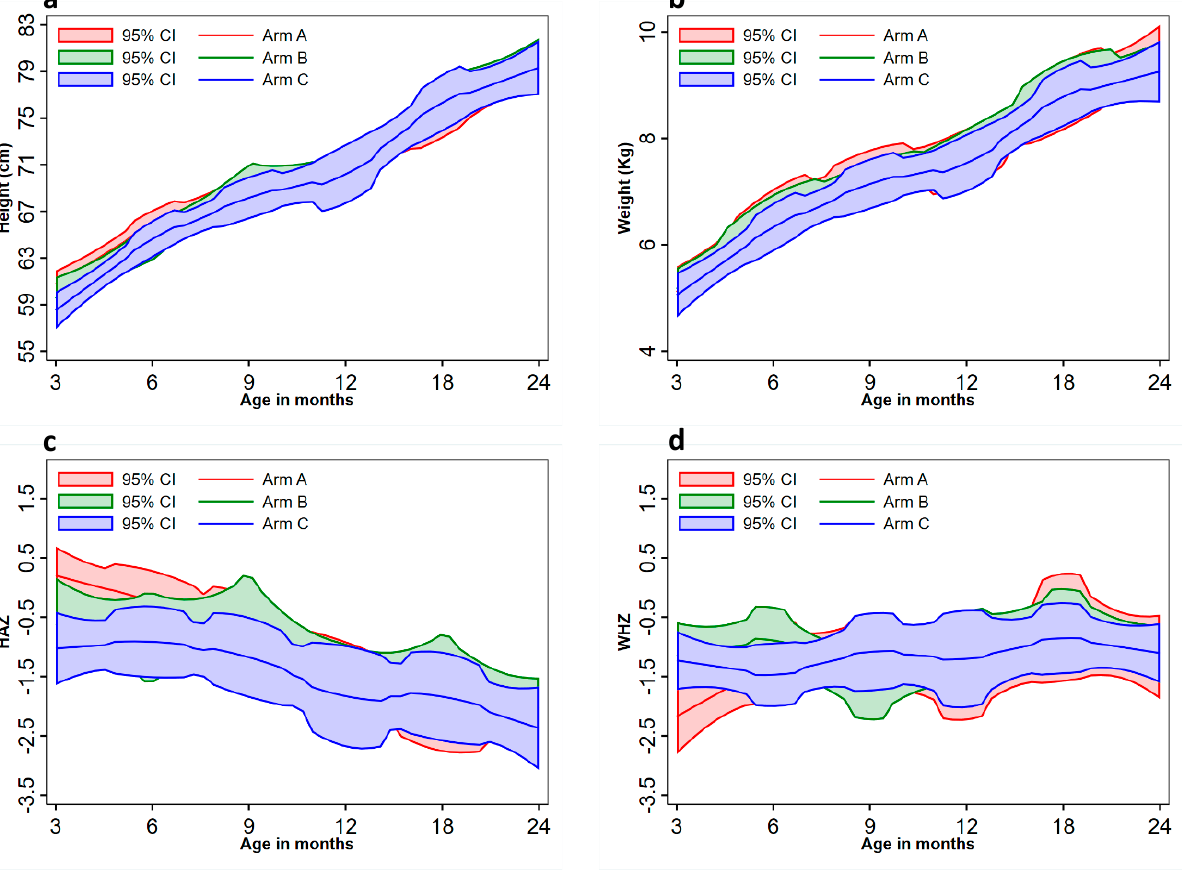
Figure 1. Growth trajectories of all children in different intervention arms: Mean ( a ) height, ( b ) weight, ( c ) HAZ (height for age) and ( d ) WHZ (weight for height) scores, and corresponding 95% CI (confi- dence intervals) for children in intervention arms A, B, and C from 3 to 24 months of age are